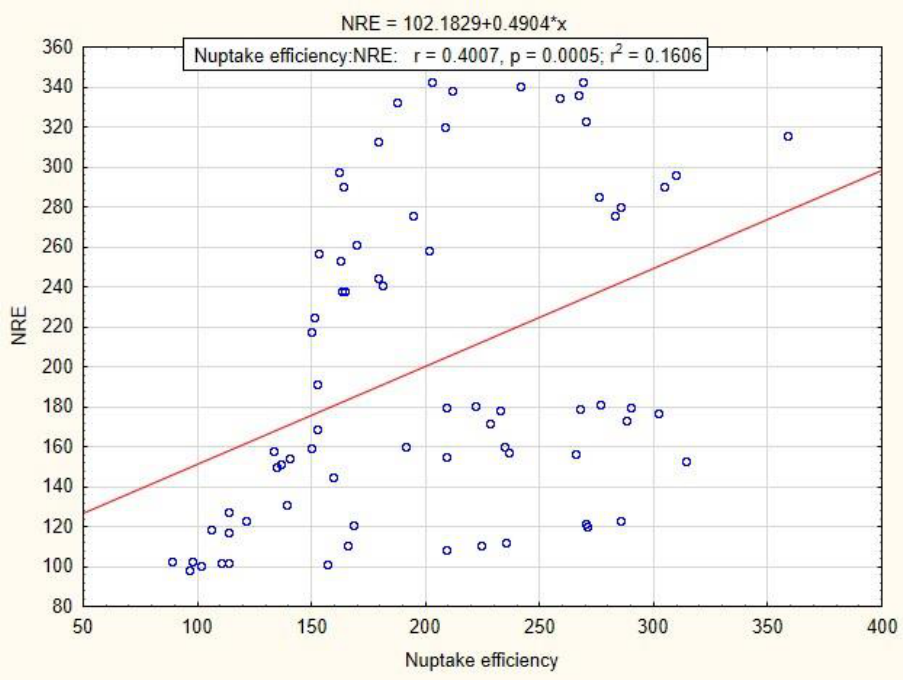
Figure 2. Correlations between N response e ffi ciency (NRE) and N uptake e ffi ciency in sown grassland.